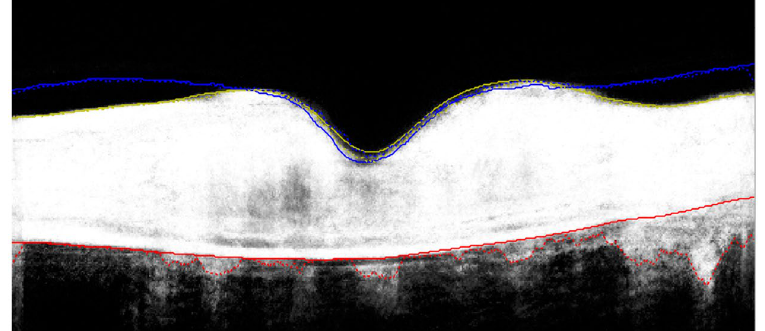
Figure 6. Prediction of the ILM-RPE class after two auto-context iterations. Solid lines: Manual annotation (ground truth); Dashed lines: Refined surface segmentation.